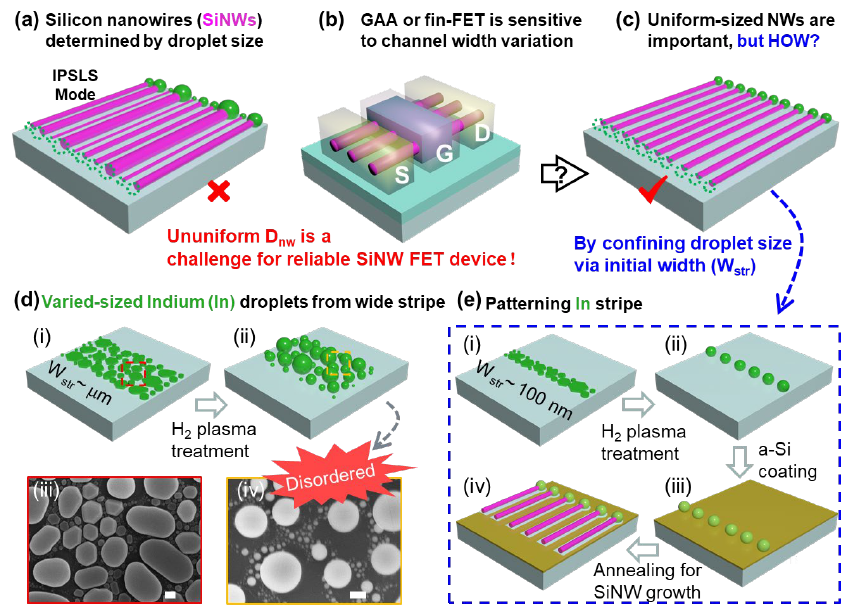
Figure 1. ( a ) Schematic illustration showing that the diameters of the SiNWs grown via IPSLS mode are determined by the size of the leading droplets. In view of serving as FET channels, in fin-gate or gate-all-around configurations, as depicted in ( b ), a uniform array of SiNW channels, for instance, those in ( c ), is highly desirable. ( d ) Panel ( i , ii ) diagram of the formation of random In catalyst droplets within the wide In stripes or planar surface, as observed in SEM images of the In grains before ( iii ) and after ( iv ) H 2 plasma treatment. In comparison, ( e ) depicts the formation of rather uniform In droplets by using a narrow In stripe with a width down to 100 nm, with the key fabrication steps depicted in ( i , ii ) catalyst formation by H 2 plasma treatment, ( iii ) amorphous silicon (a-Si) precursor coating, and ( iv ) annealing to activate the SiNW to grow by consuming the a-Si layer. Scale bars in panels ( iii , iv ) in ( d ) are all for 200